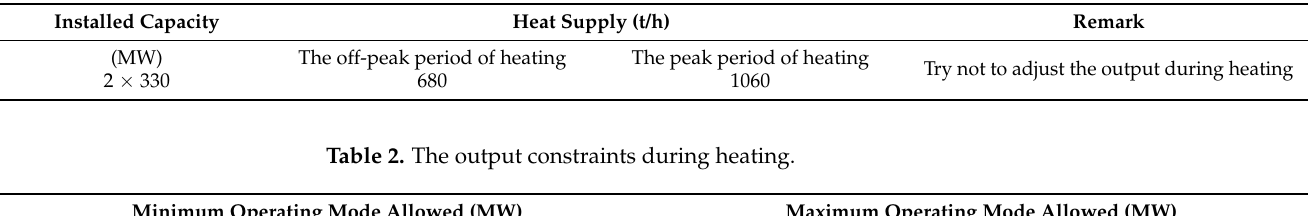
Table 1. The heating situation of the thermal power plant.